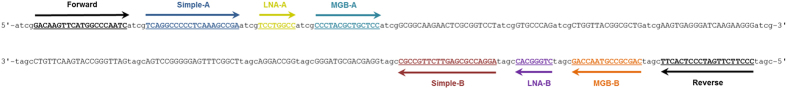
Schematic representation of synthetic nucleic acid standard.The 162 nucleotides-long sequence starts with a four-nucleotide tag, followed by a pair of primers (in black, underlined). The amplicon contains six probe binding motifs, three located downstream of the forward primer and three located downstream of the reverse primer. For abbreviations and further details, please refer to Fig. 2.